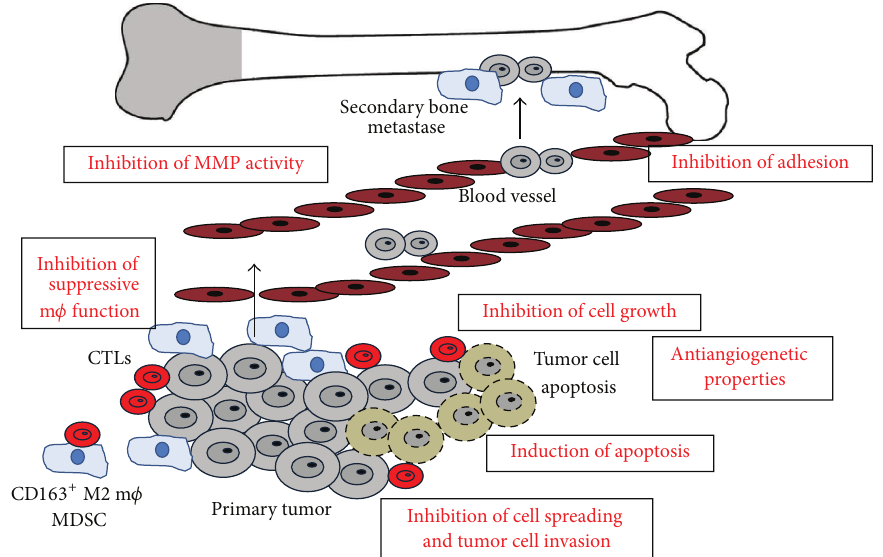
Figure 4: Schematic representation of antitumor effect of BPs. BPs might suppress the progression of EMPD as follows: induction of tumor apoptosis, inhibition of the function of immunosuppressive macrophages, inhibition of tumor adhesion, inhibition of tumor invasion, and inhibition of MMP